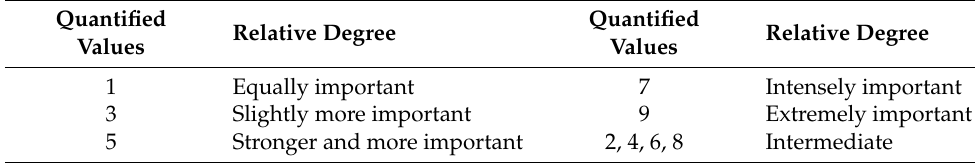
Table 4. Numerical quantification of the hierarchical analysis